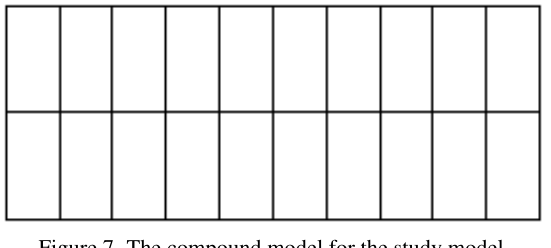
Figure 7. The compound model for the study model